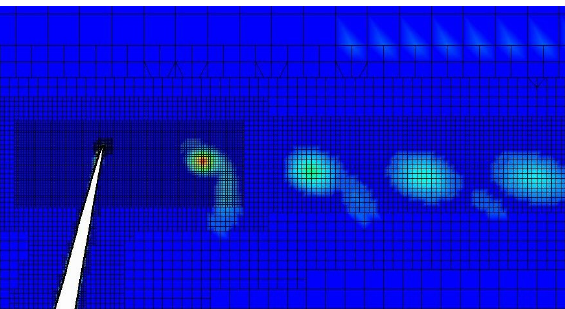
Figure 3. Volumetric control refinement for the tip vortex.